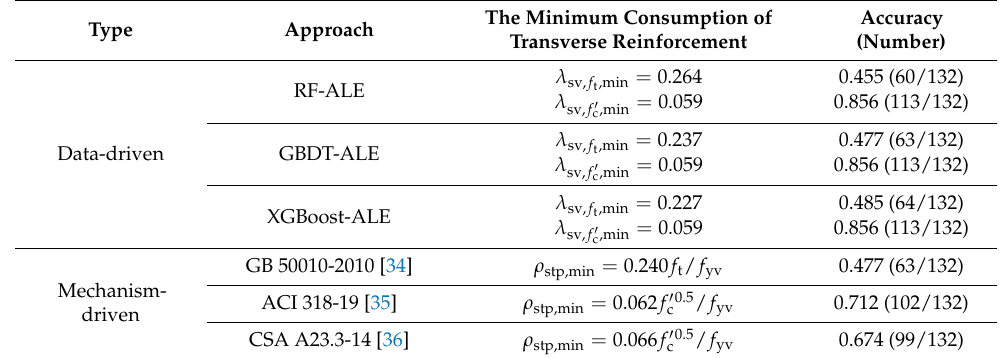
Table 3. The minimum consumption of transverse reinforcement for RC beams with transverse re- inforcements and their classification results.